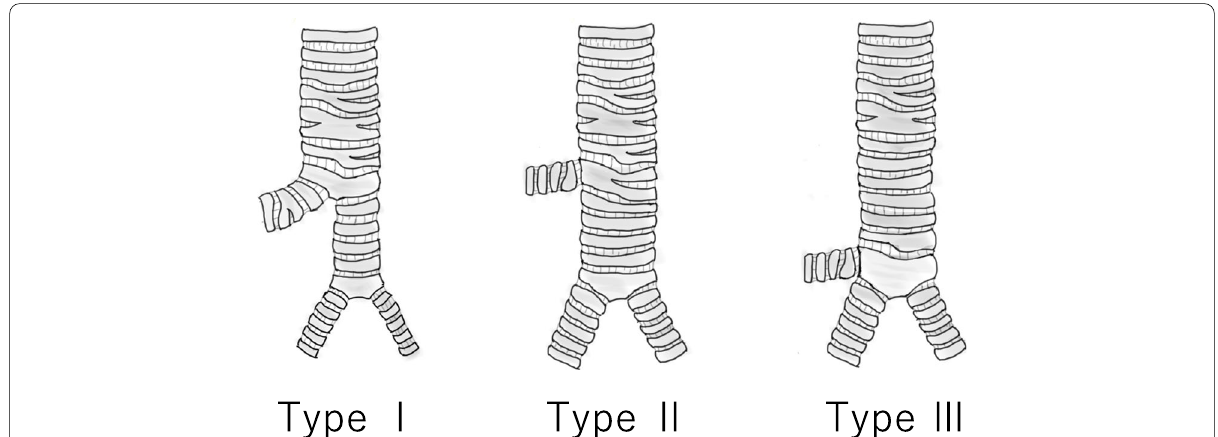
Fig. 3 Modified schematic diagram of right TB classification (Conacher’s classification) [9]. Types I and II: the right TB is distant (> 2 cm) from the tracheal bifurcation. The distal trachea is either a narrow bronchial structure (type I) or a normal tracheal structure (type II). Type III: the right TB is close (< 2 cm) to the tracheal bifurcation and appears as a three-branching structure. TB: tracheal